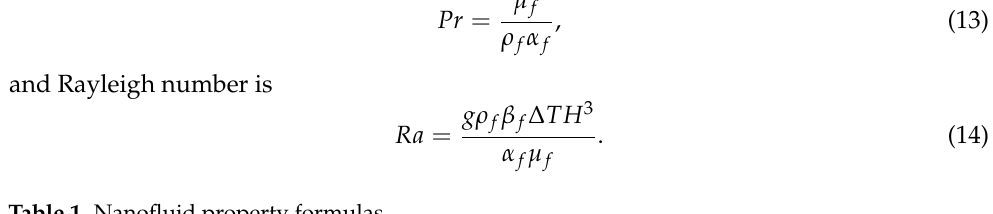
Table 1. Nanofluid property formulas.